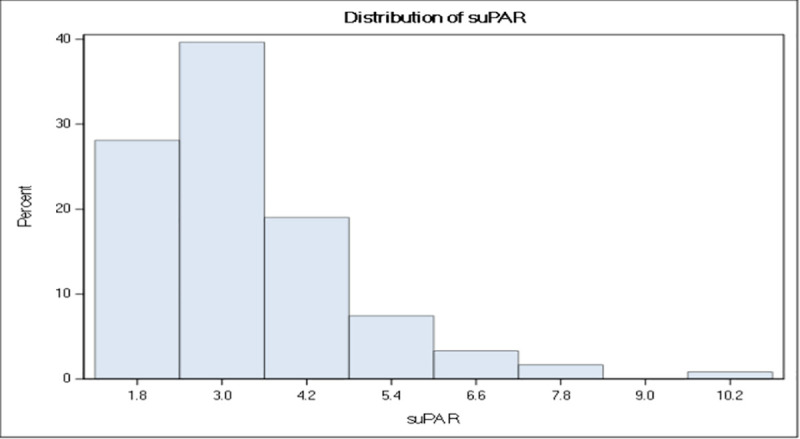
Concentration range of suPAR.Histogram showing the distribution of suPAR concentrations (ng/mL) in the study population.